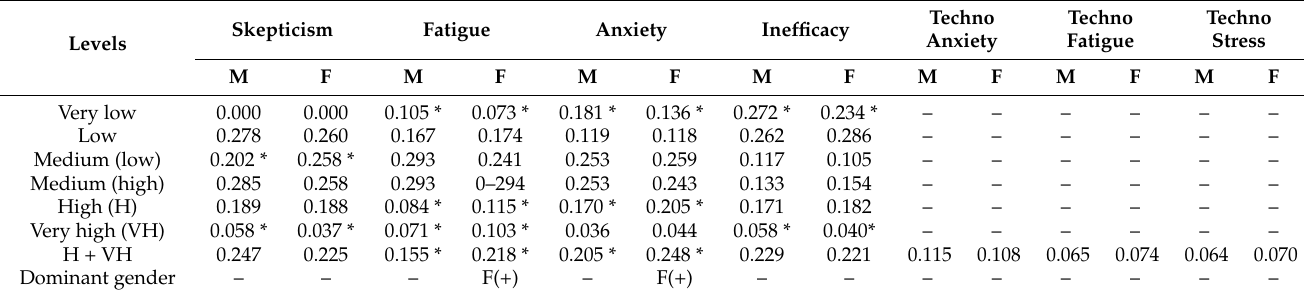
Table 7. Test of proportions for level by gender in technostress, manifestations and dimensions.